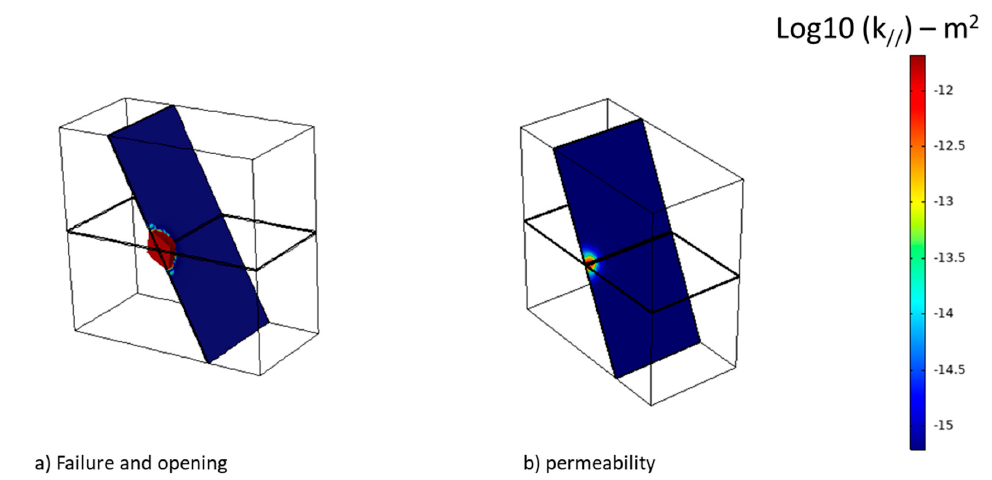
Figure 5. Fault failure and opening and permeability at highest injection pressure. ( a ) The deformed shape is shown with a high degree of exaggeration. The failure zone is shown in red and corresponds to the largest opening of the fault. ( b ) The distribution of permeability parallel to the fault plane is shown in log scale.